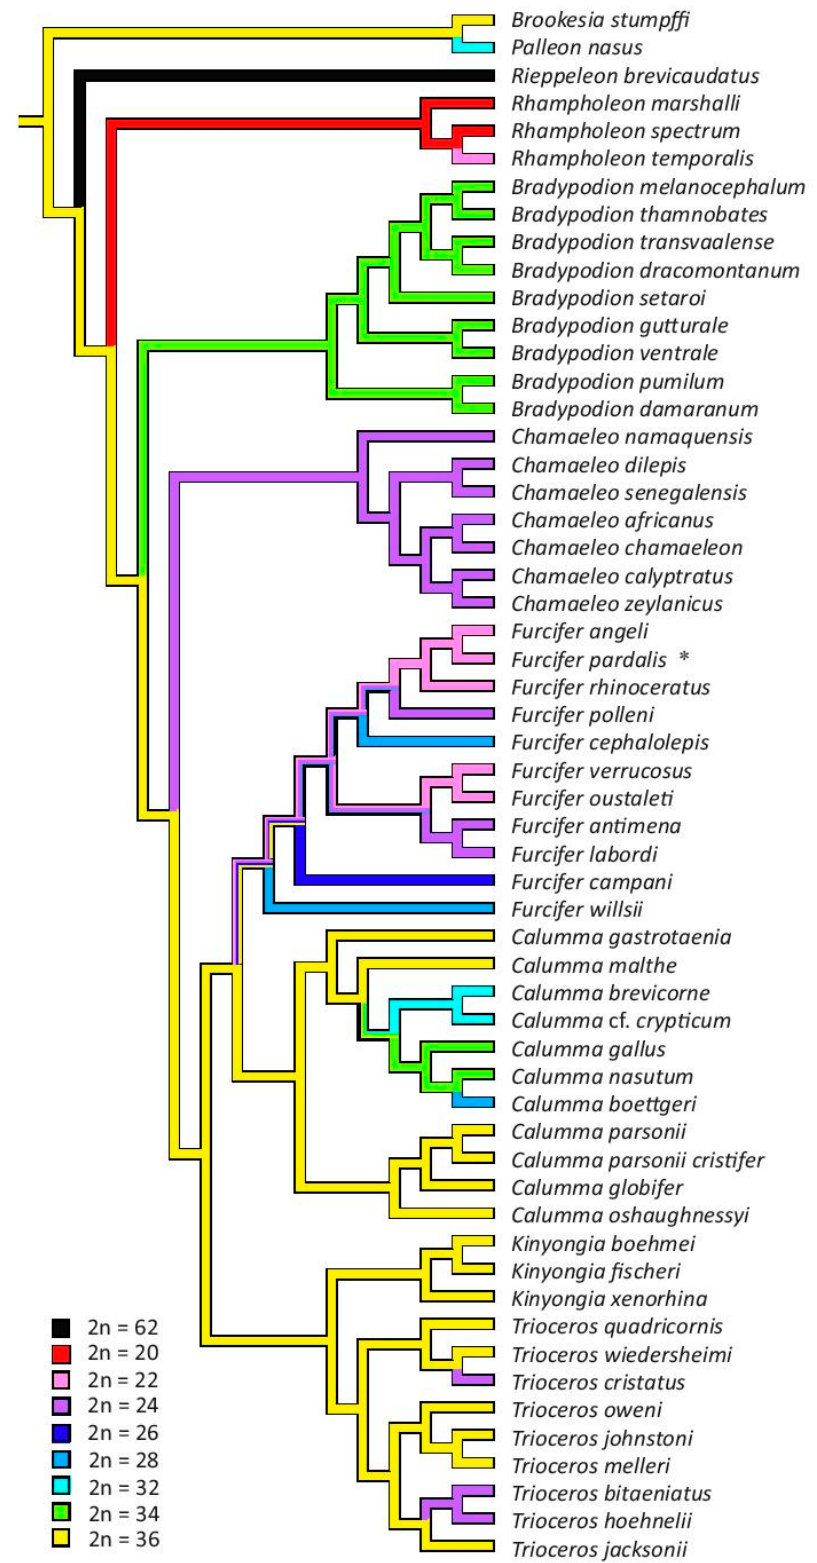
Figure 6. Phylogenetic analysis based on tree by [1] with depicted number of chromosomes. Results of maximum parsimony analysis reconstructing ancestral chromosome number are visualized by colours of the branches. Asterisk (*) symbolises different chromosome number in female of Furcifer pardalis due to presence of neo-sex chromosomes.